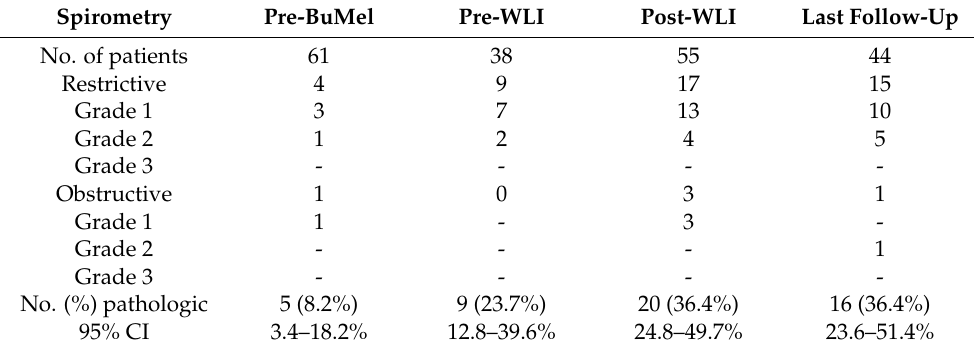
Table 2. Pathologic spirometry–incidence and